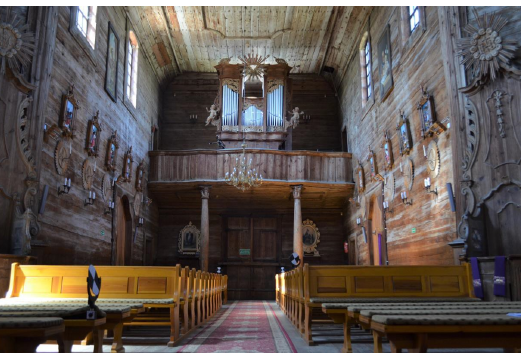
Figure 4. Music choir in the church of St. Szczepan in Mnichów (source: private archive). The Mnichów church is a very valuable monument of Polish religious architecture.